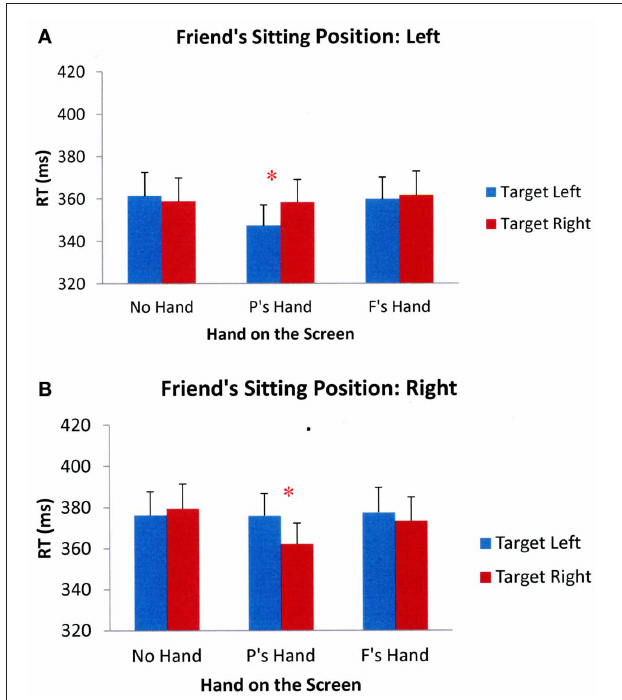
FIGURE 3 | Mean reaction times across all participants in different Experimental conditions of Experiment 1 when a friend was sitting to the participants’ left (A) and right (B). Error bars represent standard errors of the means. (Note: P’s = Participant’s; F’s = Friend’s). ∗ p < 0 .